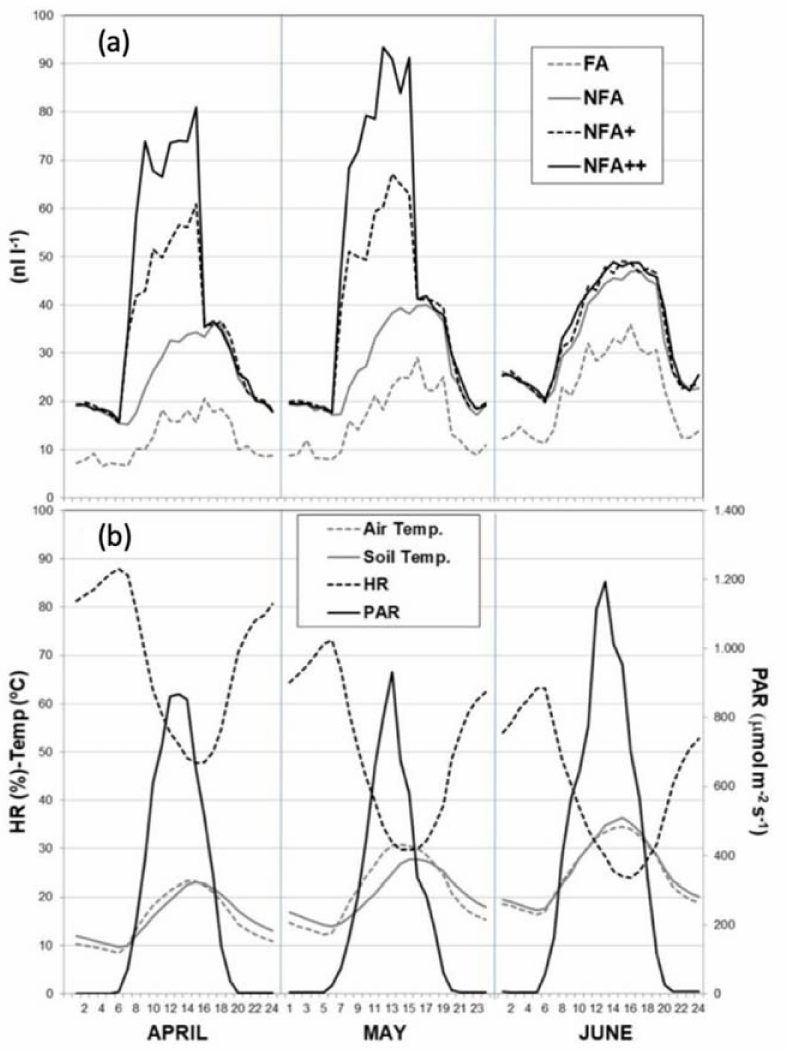
Figure 2. ( a ) Mean daily profiles of O 3 concentration for the different O 3 -treatments during the experimental period: FA = charcoal filtered air, NFA = non filtered air, NFA+ = non filtered air supplemented with 20 nL L − 1 of O 3 , NFA++ = non filtered air supplemented with 40 nL L − 1 of O 3 ; ( b ) Mean daily profiles of meteorological parameters during the exposure period inside the OTCs: HR (%,), air and soil temperature ( ◦ C) and photosynthetic active radiation (PAR µ mol m − 2 s − 1